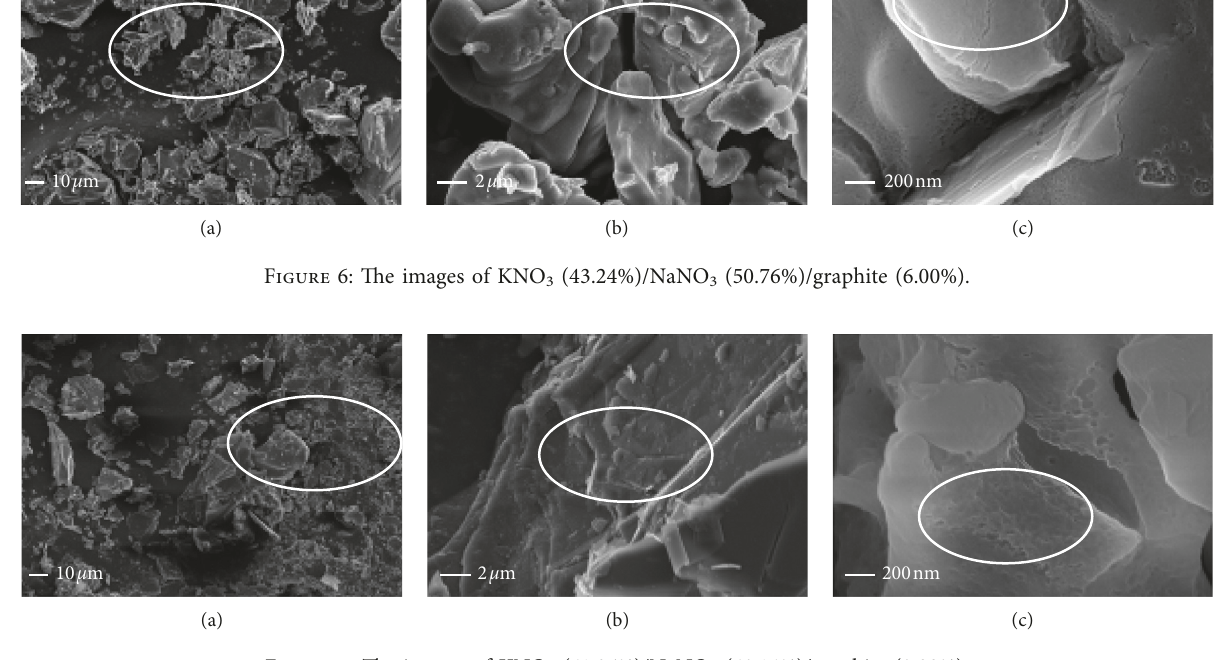
Figure 7: The images of KNO 3 (41.86%)/NaNO 3 (49.14%)/graphite